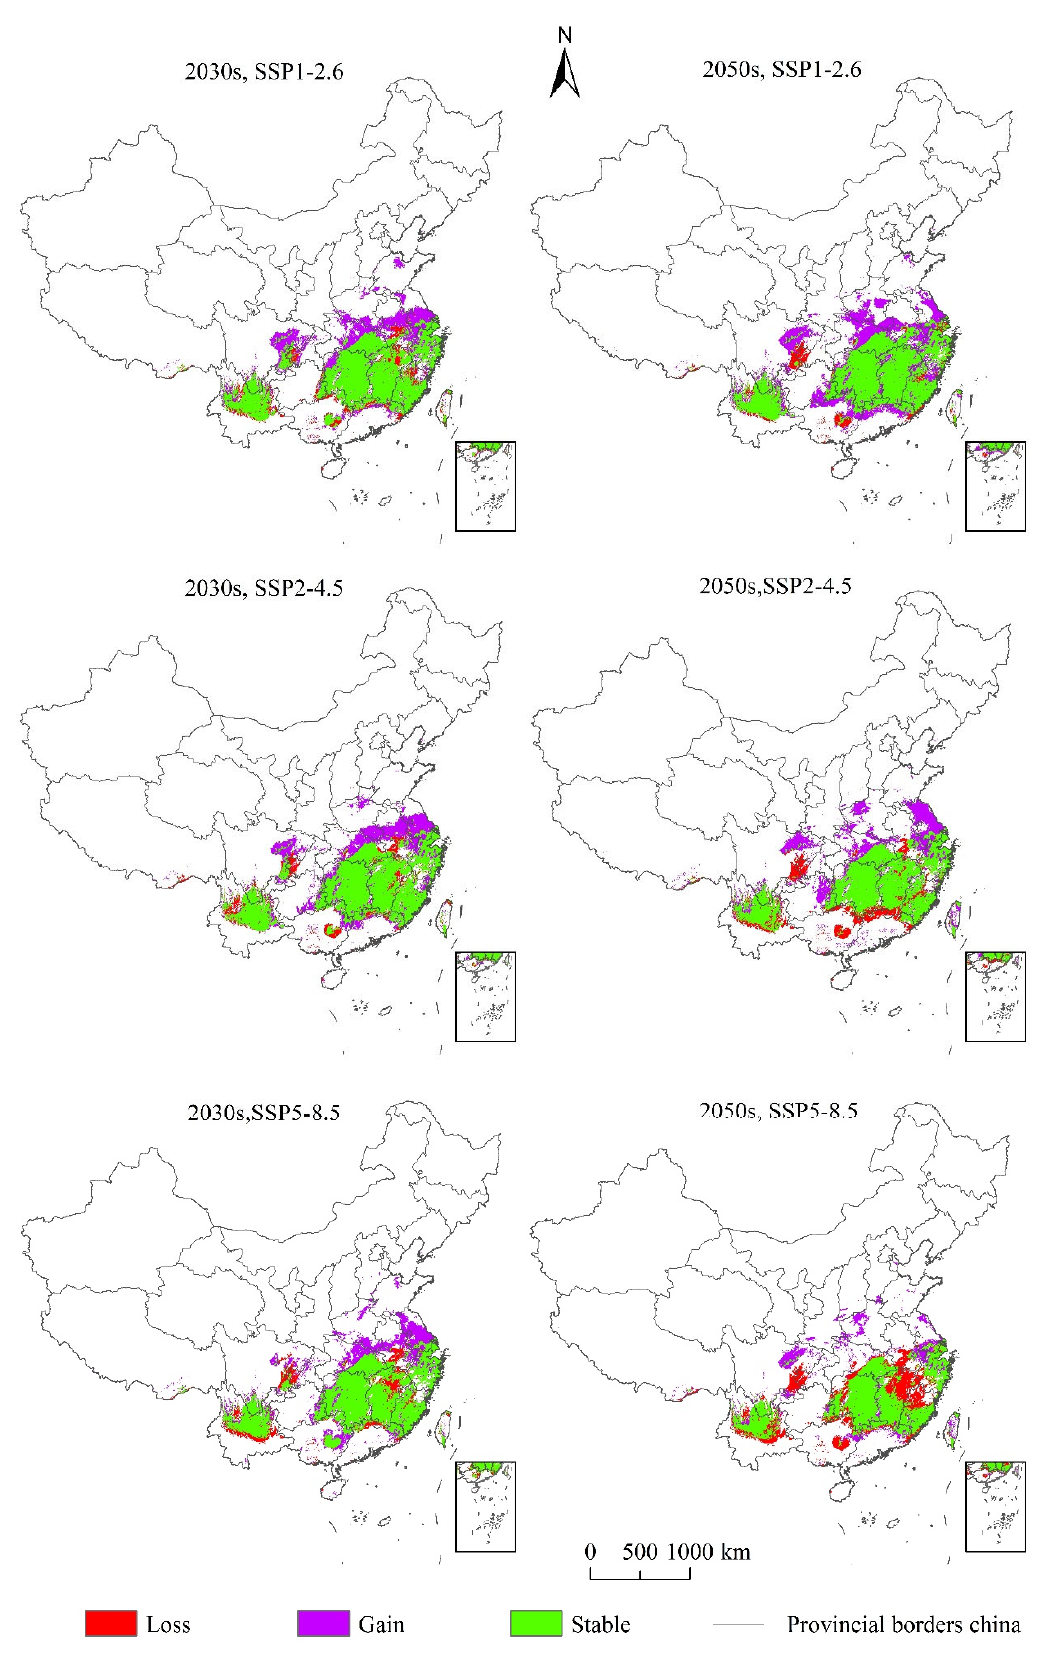
Figure 8. Changes in potential suitable areas for Linepithema humile between the current and future climatic scenarios in China.